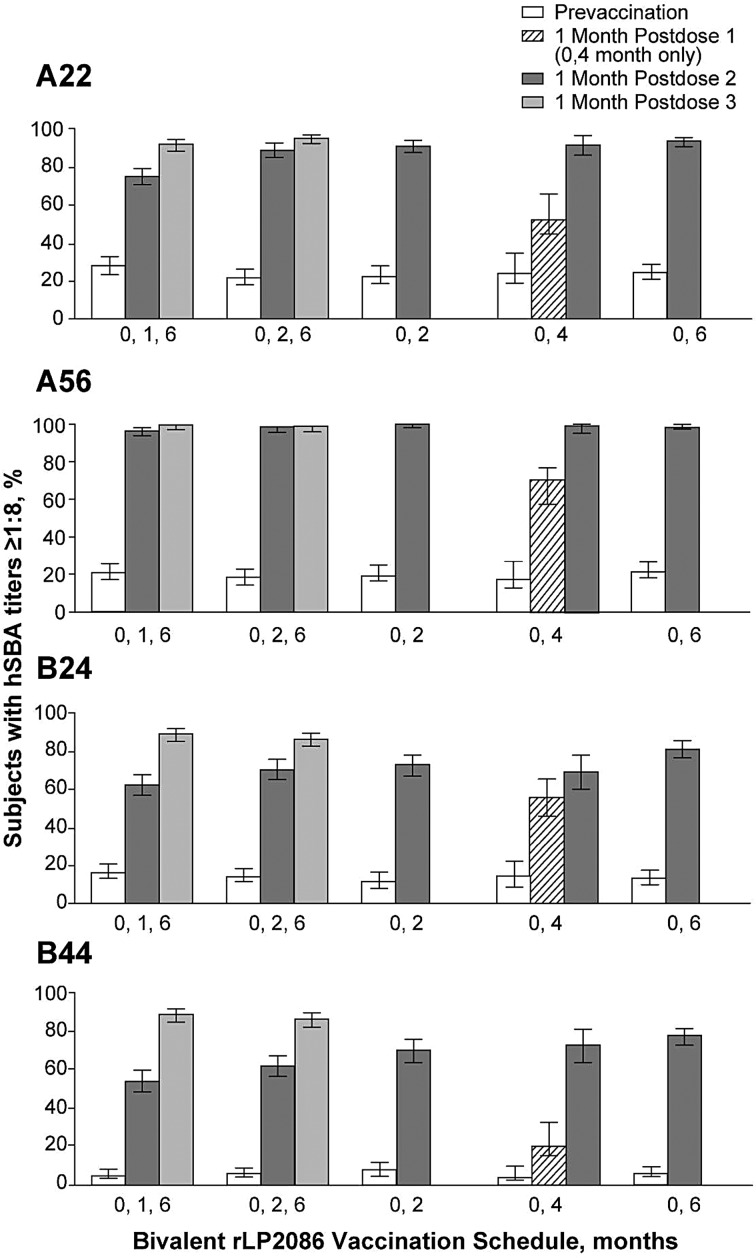
Percentage of subjects with hSBA titers ≥1:8 against N meningitidis serogroup B test strains A22, A56, B24, and B44 at baseline and 1 month after injection with bivalent rLP2086 or saline. Errors shown are 95% confidence intervals. hSBA, human serum bactericidal antibody assay using human complement.